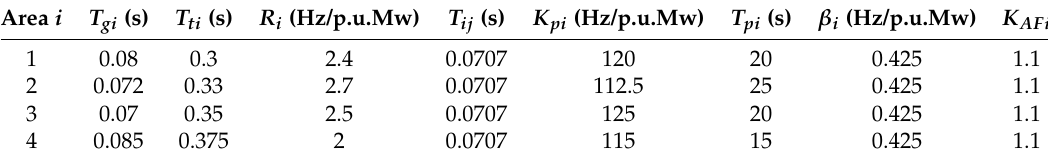
Table 2. Parameters of a four-area MIPS.